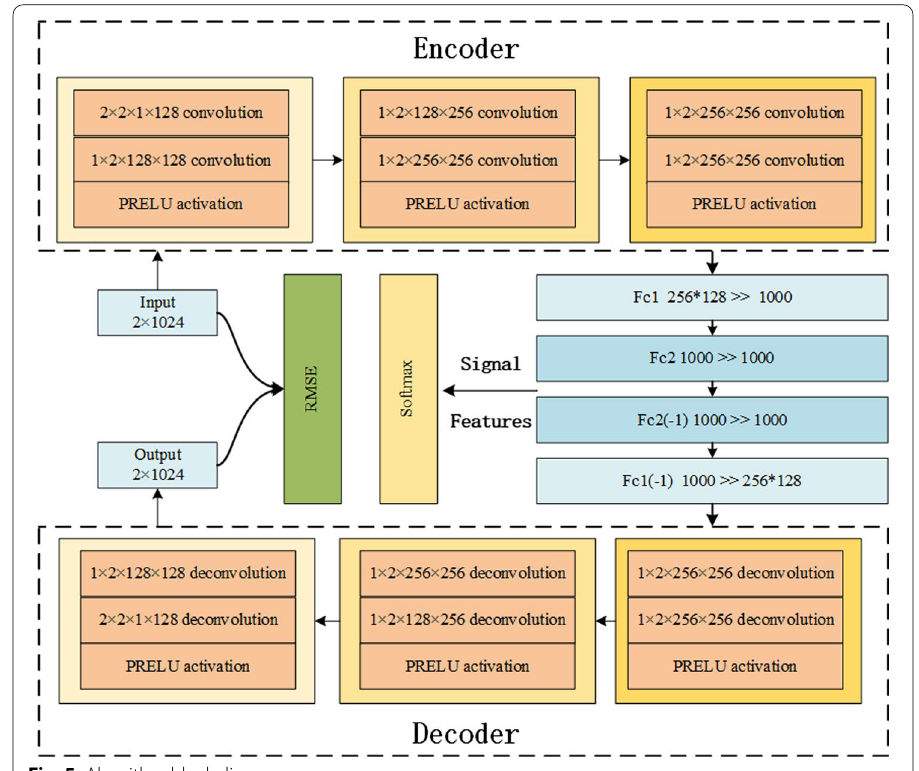
Fig. 5 Algorithm block